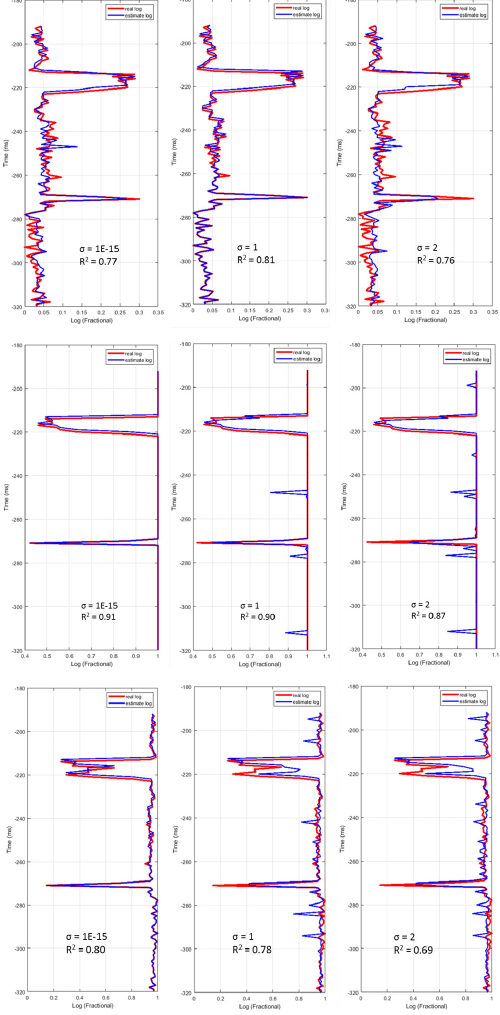
Figure 9. Effect of smoothing factor ( σ ) to the petrophysical prediction accuracy (R 2 ), Porosity prediction (1st row), water saturation prediction (2nd row), and volume of shale (3rd row).